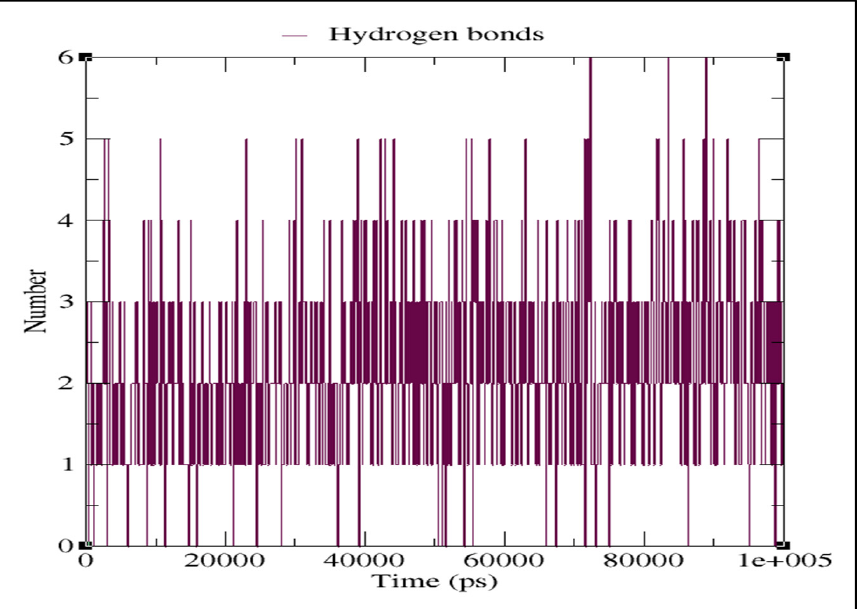
Figure 5. Hydrogen bonds (HBonds) plot for the docked complex of Pseudohypericin with COVID-19 main protease.